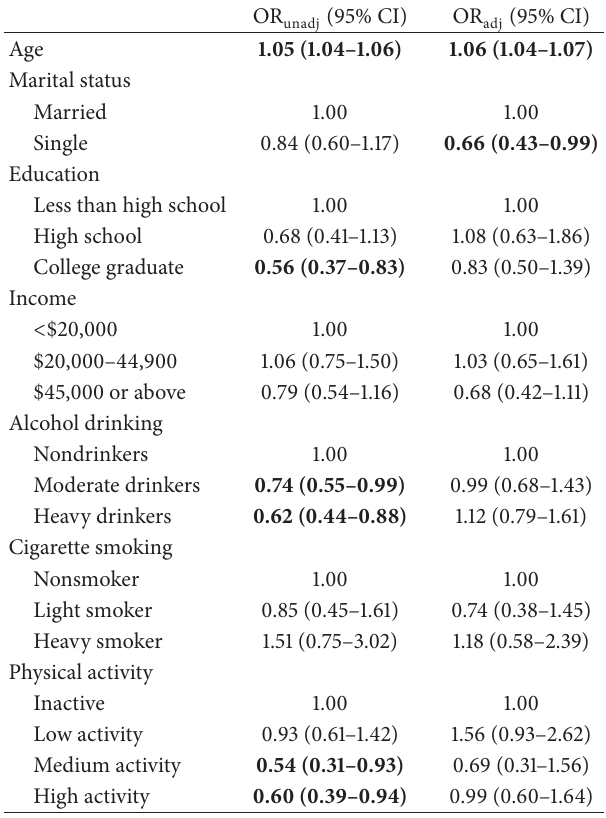
Table 2: Predictive factors for metabolic syndrome among African American men using weighted estimates: from the NHANES 1999– 2006 ∗ .